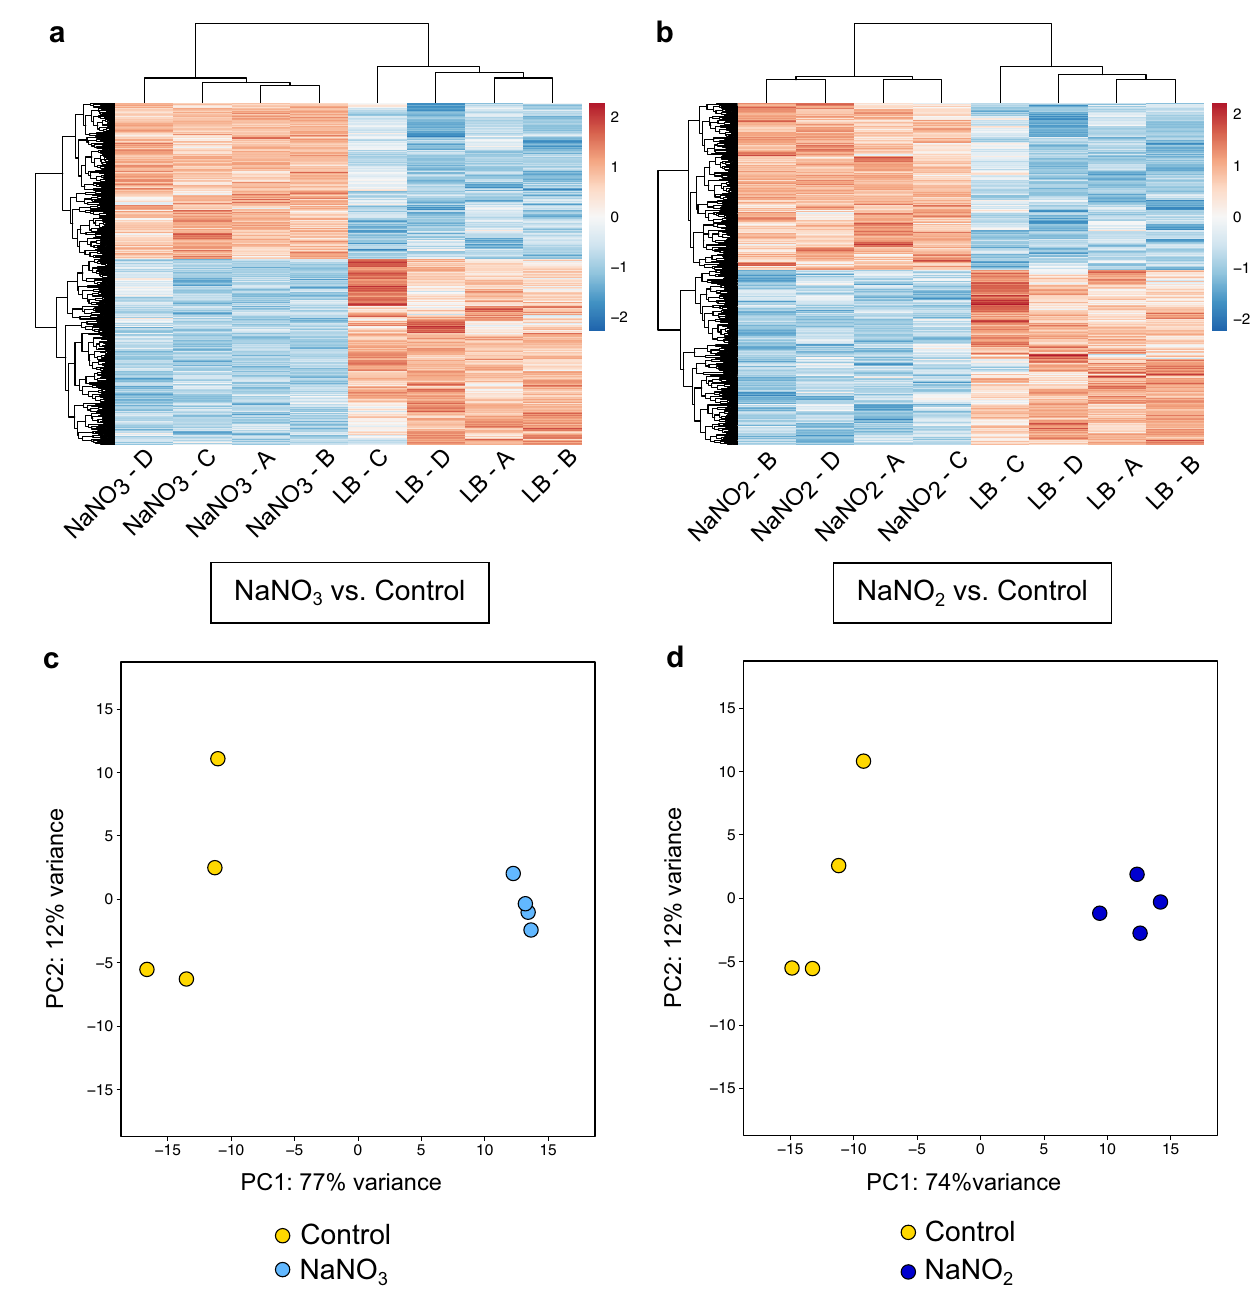
Figure 2. Clustering analyses reveal divergent datasets in the differential expression patterns among wild type samples in both NO 3− and NO 2− treatment conditions. Z-score analysis of all differentially regulated transcripts for NaNO 3 vs. Control ( a ) and for NaNO 2 vs. Control ( b ). Principal component analysis of entire datasets for NaNO 3 vs. Control ( c ) and for NaNO 2 vs. Control ( d ). The control condition is un-supplemented LB media. Hierarchical clustering of all significantly expressed transcripts are presented in panels A and B and principal component analyses represent the complete transcriptomes of all samples as depicted in panels C and D. Principal components were calculated using the regularized log transformation of raw transcript count data in the DESeq2 package. The regularized log-transformed transcript counts from DESeq2 were input into the pheatmap package in R, whereby the data were scaled to Z-scores by rows/genes automatically. Four biological replicates were included for all analyses